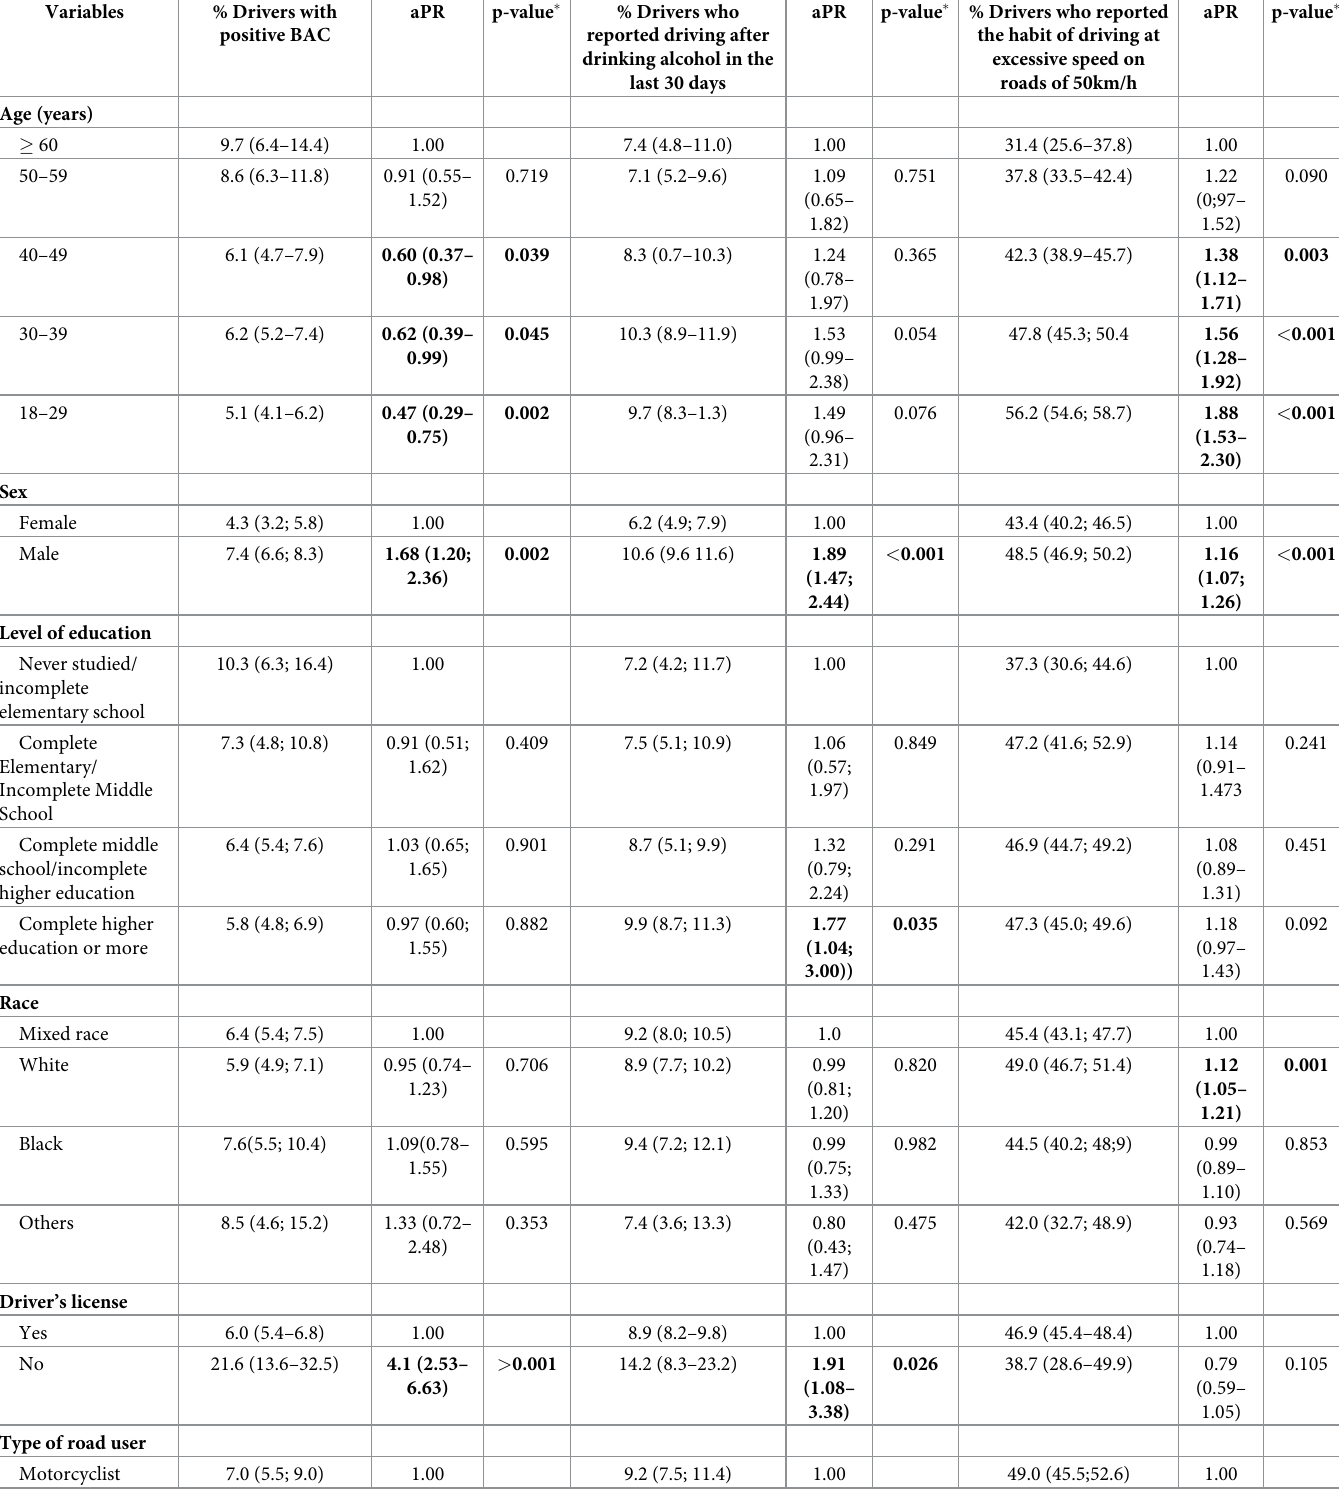
Table 2. Prevalence of risky behaviors associated with traffic crashes in the 14 Brazilian capitals participating in the life in traffic project and adjusted prevalence ratio by age, sex, education, race and type of road user, 2019.